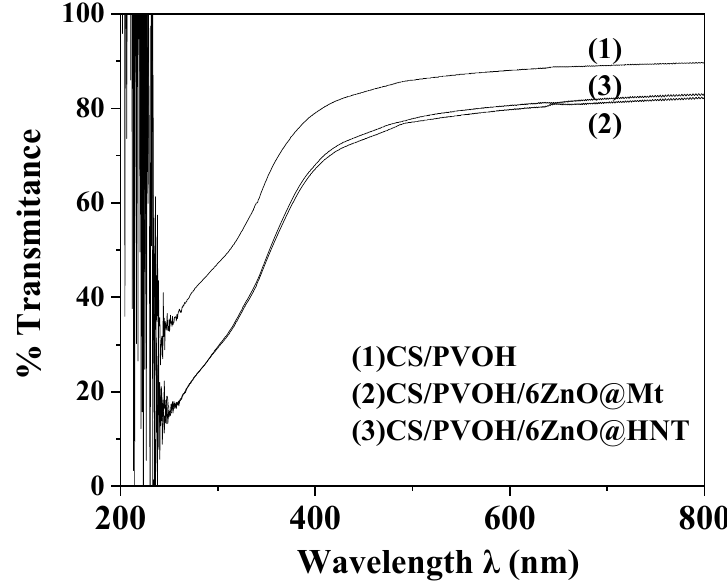
Figure 8. UV–vis % transmittance of (1) CS/PVOH, (2) CS/PVOH/6ZnO@Mt, and (3) CS/PVOH/6ZnO@HNT in the range of 200 to 800 nm.